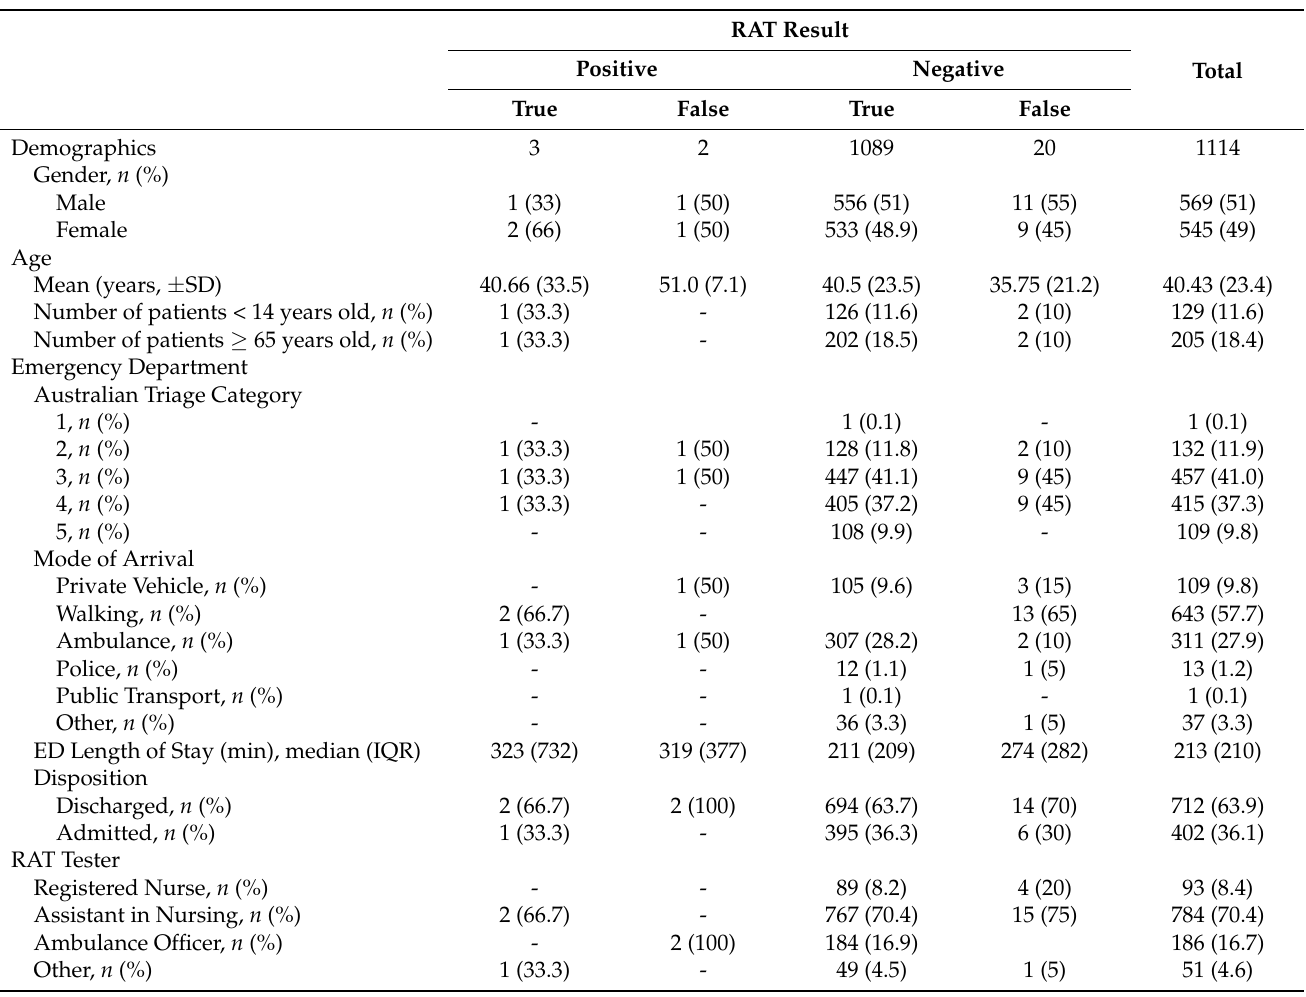
Table 1. Characteristics of patients who presented to the ED without COVID-19 symptoms and had an RAT and RT-PCR result.